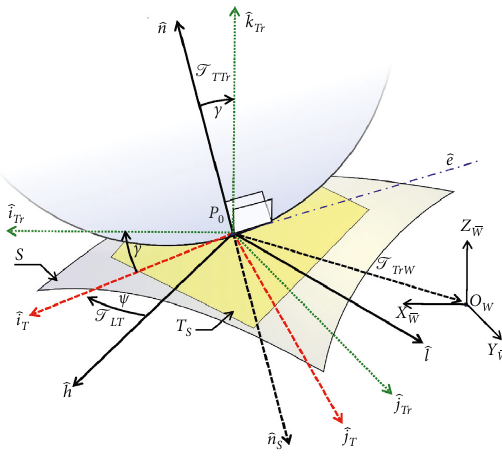
Figure 2: Schematic diagram of reference frames, Euler axis 􏽢 e , and transformations between reference